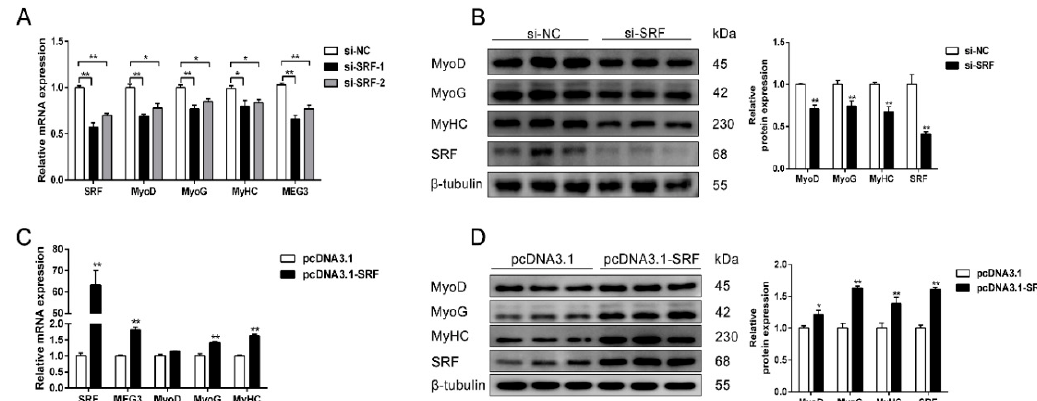
Figure 6. SRF promotes the di ff erentiation of porcine satellite cells. ( A ) qPCR results showing that SRF knockdown significantly decreases the expression levels of MEG3 , MyoD , MyoG , and MyHC in in porcine satellite cells di ff erentiated for 48 h. ( B ) Western blot analysis results showing SRF knockdown significantly decreases the protein expression of SRF and the di ff erentiation marker genes. ( C , D ) qPCR ( C ) and Western blot ( D ) results showing SRF overexpression significantly increases the expression levels of MEG3 and promotes porcine satellite cell di ff erentiation. The relative mRNA levels were normalized to those of the control 18S rRNA . The relative protein levels were normalized to those of the control β -tubulin . Error bars represent mean ± SEM of three biological replicates. Statistical significance of di ff erences was assessed by Student’s t -test. * p < 0.05, ** p < 0.01. NC, negative control. qPCR, quantitative real-time polymerase chain reaction.